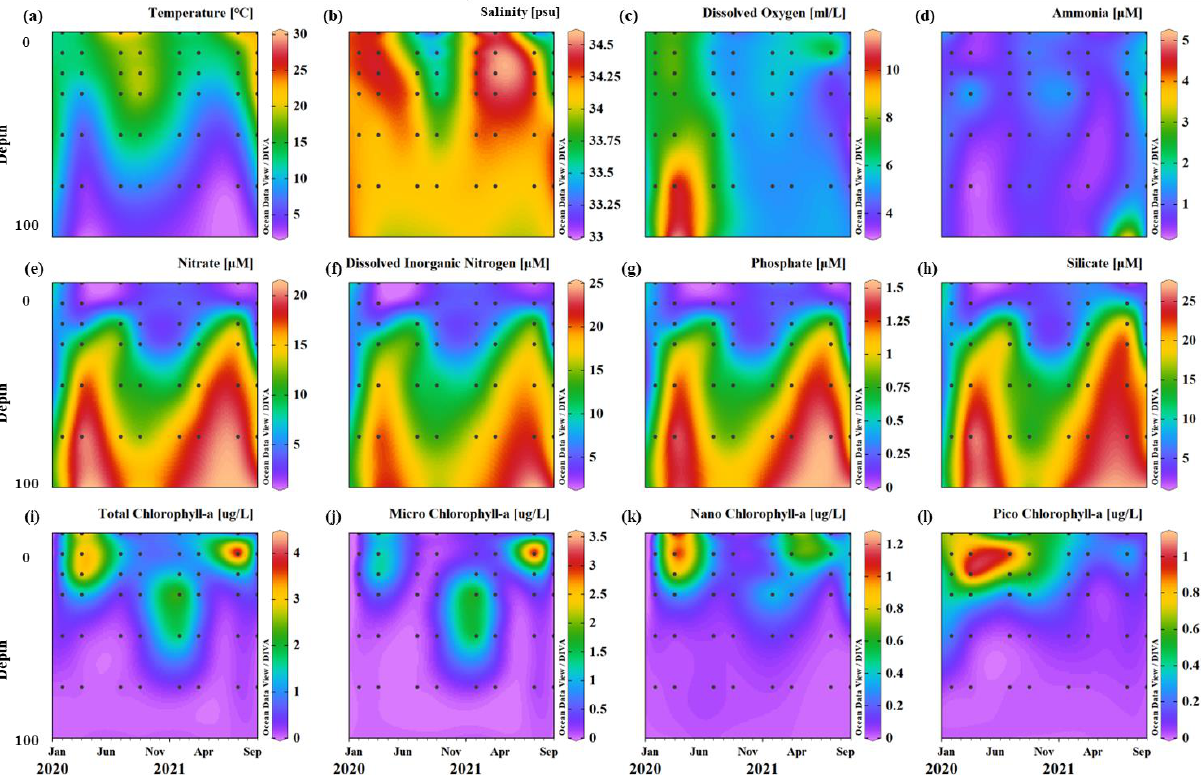
Figure 2. Monthly variation of temperature ( a ), salinity ( b ), dissolved oxygen ( c ), NH 4+ concentration ( d ), NO 32 − concentration ( e ), dissolved inorganic N concentration ( f ), PO 43 − concentration ( g ), SiO 32 − concentration ( h ), total chlorophyll- a concentration ( i ), micro chlorophyll- a concentration ( j ), nano chlorophyll- a concentration ( k ), and pico chlorophyll- a concentration ( l ) from 0 to 100 m in site 105-05. The white triangular mark indicates the month in which the zooplankton samples were collected.